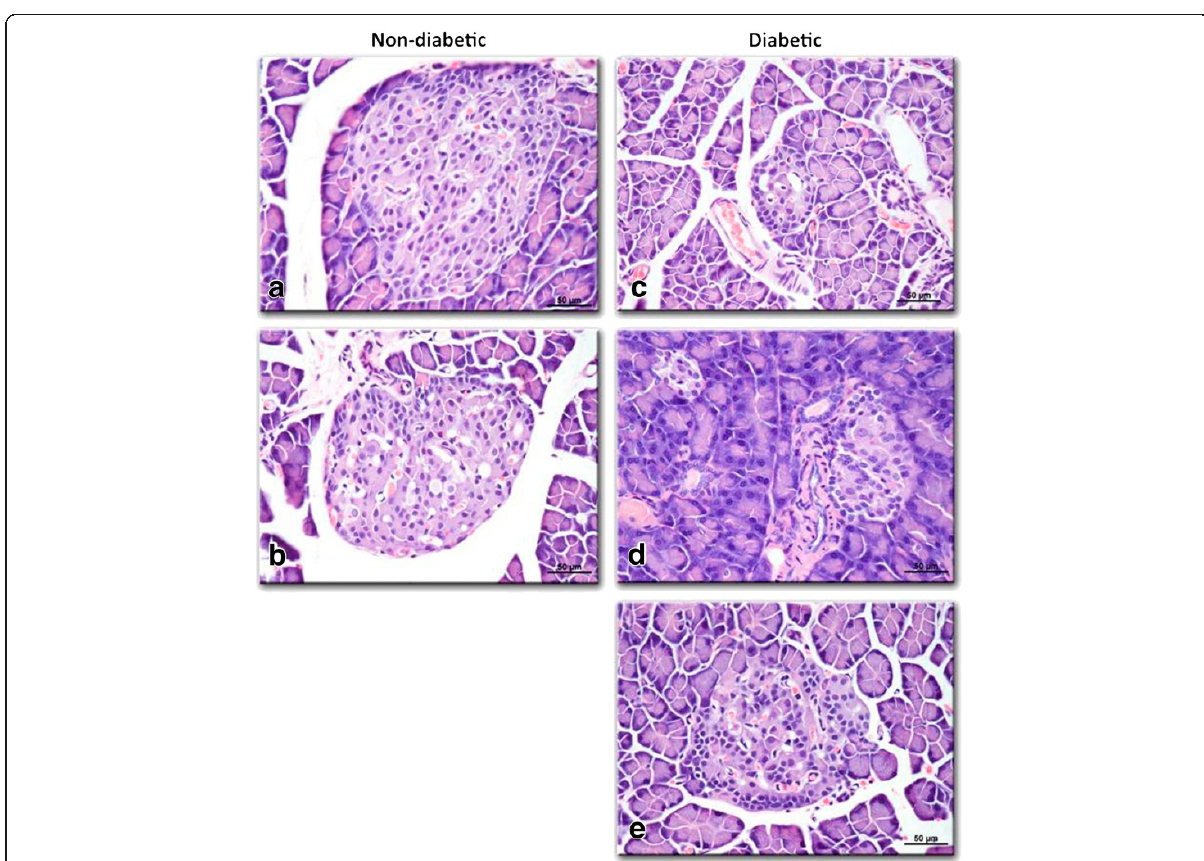
Figure 1 Effect of aqueous extract of C. papaya leaves on the histological of rat pancreas evaluated by hematoxylin and eosin (H&E) staining (50X). a ) Shows the Normal aspect of a Langerhans islet. b ) Pancreas of non-diabetic rat treated with 1.5 g/100 mL showing a reduced Langerhans islet with smaller size with respect to a ). c ) Diabetic rat pancreas without treatment showing a small Langerhans ’ islet due to streptozotocin injury. In contrast, diabetic rats treated with C. papaya leaf extract showed larger Langerhans ’ islets for all doses: ( d ) 0.75 g/100 mL e ) 1.5 g/100 mL. Hematoxylin-eosin staining,